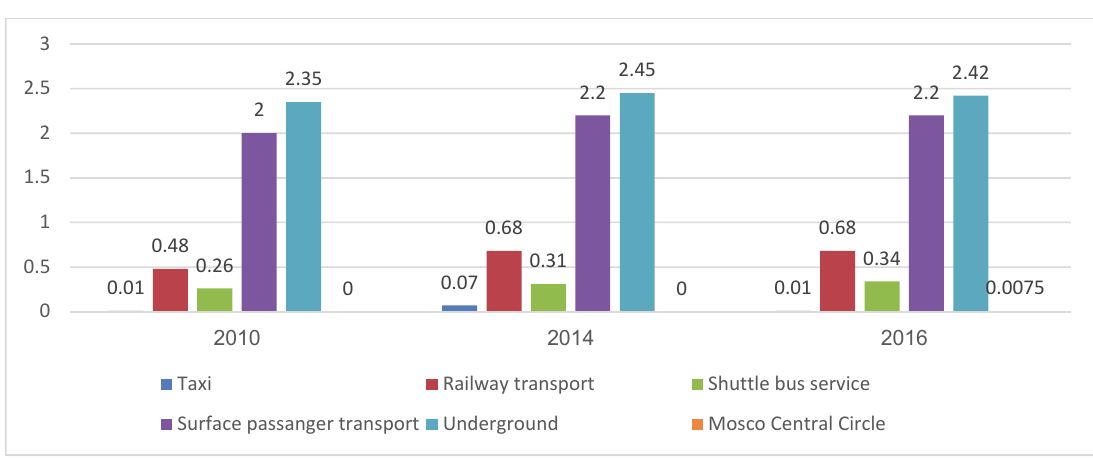
Fig. 3. Volume of passenger transportation in Moscow, billion people